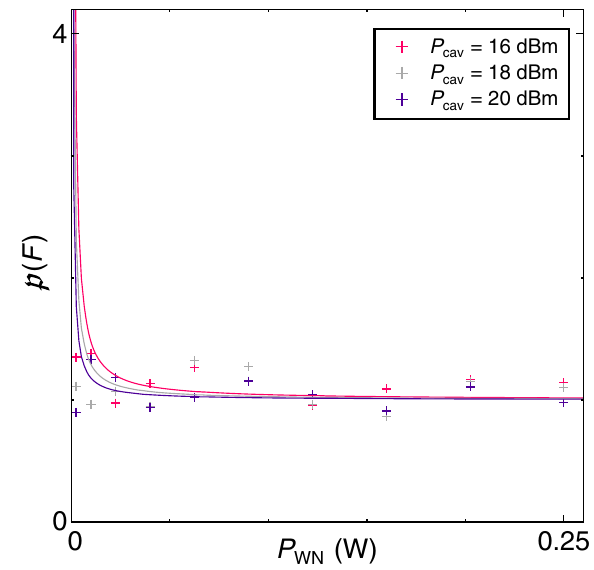
FIG. 7. Precision p ð F Þ of the demodulated signal as a function of mechanical drive power P for different settings of the cavity WN illumination power P in the range 16 – 20 dBm. Crosses show cav precision calculated from the voltage record data using Eqs. (4) and (7). Curves show predictions from Eq. (C31). The free 8 dBm, then parameter α is set by fitting to the data with P cav ¼ held fixed to generate the other